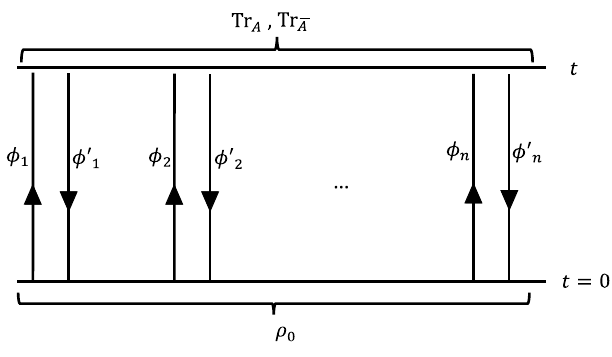
FIG. 1. The path integrals Eq. (13) for Eq. (11) involve 2 n inte- gration contours, with those for U ’s going forward in time and those for U † backward in time. ρ 0 provides the initial conditions while the contractions implied by the traces in Eq. (11) define the final conditions for the path